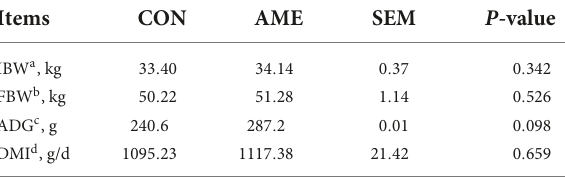
TABLE 2 Effect of AME on the growth performance of lambs.